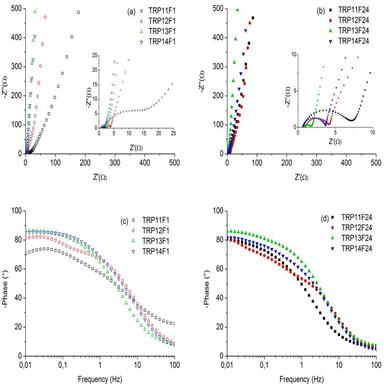
Nyquist (a, b) and Ragone (c, d) plots of F-doped SiOC-DC etched during 1 or 24 h.